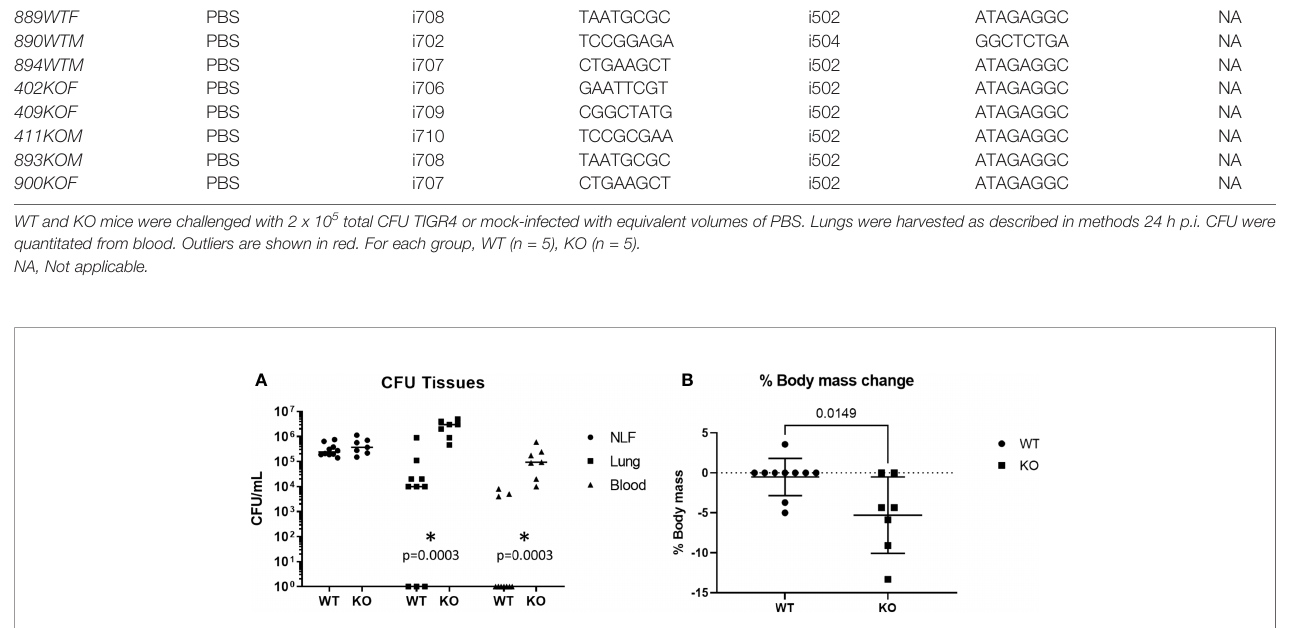
FIGURE 1 | Puma attenuates sepsis and morbidity. (A) Mice were intranasally challenged with 2 x 10 5 total CFU. Pneumonia was allowed to develop for 24 h, at which time mice were euthanized and tissues were sampled. For each group, WT ( n = 10), KO ( n = 7). Horizontal lines represent means. A Mann-Whitney U test was performed, a = 0.05. (B) Mice were weighed immediately before challenge and before sacri fi ce. A two-tailed, unpaired T-test was performed, a = 0.05. *p = 0.0003.